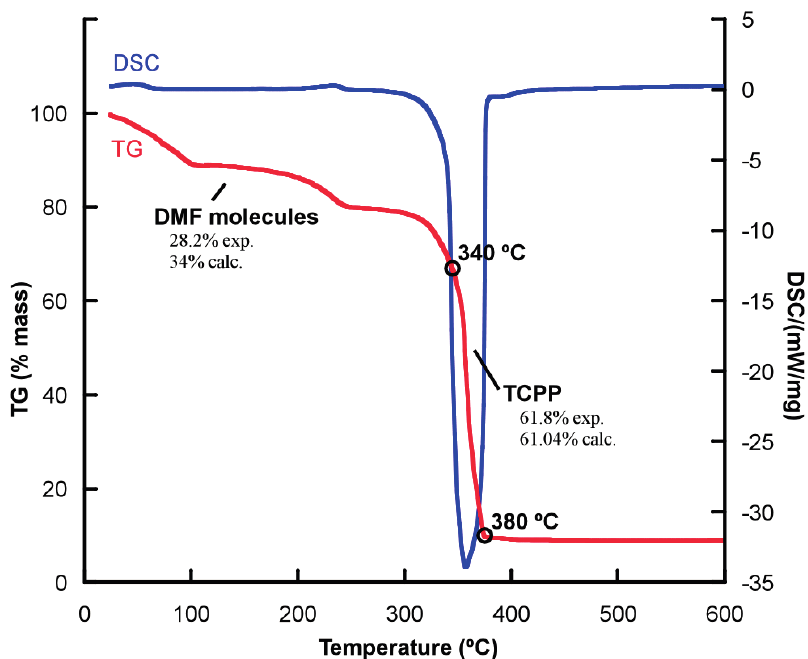
Figure 5. Thermogravimetric analysis for compound 1 .